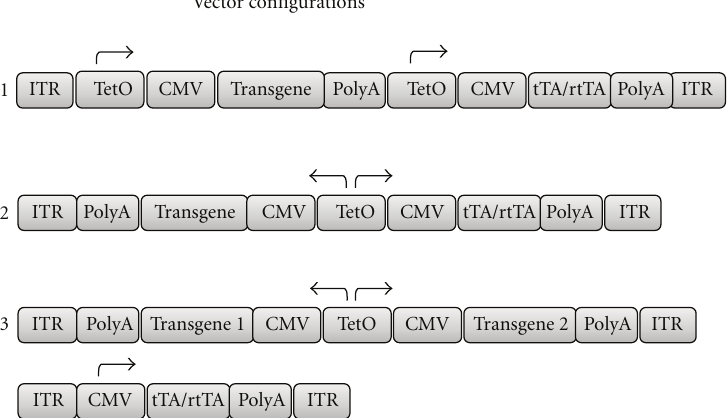
Figure 2: Di ff erent configurations the tetracycline system has been incorporated into viral vectors for use in the brain. (1) Two right-facing cistrons direct transactivator and transgene expression in a single vector [4–7]. (2) One bidirectional promoter driving expression of the transgene and transactivators in a single construct [5, 6, 8–10]. (3) Two vectors are used: one bidirectional construct directing expression of two transgenes and one driving expression of transactivators [11, 12]. ITR: inverted terminal repeats; PolyA: polyadenylation signal; TetO: tetracycline operator sequence; CMV: cytomegalovirus; tTA: tetracycline transactivator; rtTA: reverse tetracycline